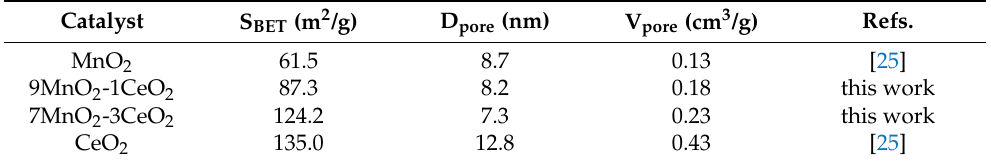
Table 1. BET surface areas, pore volumes, and pore sizes of catalysts synthesized from KIT-6.